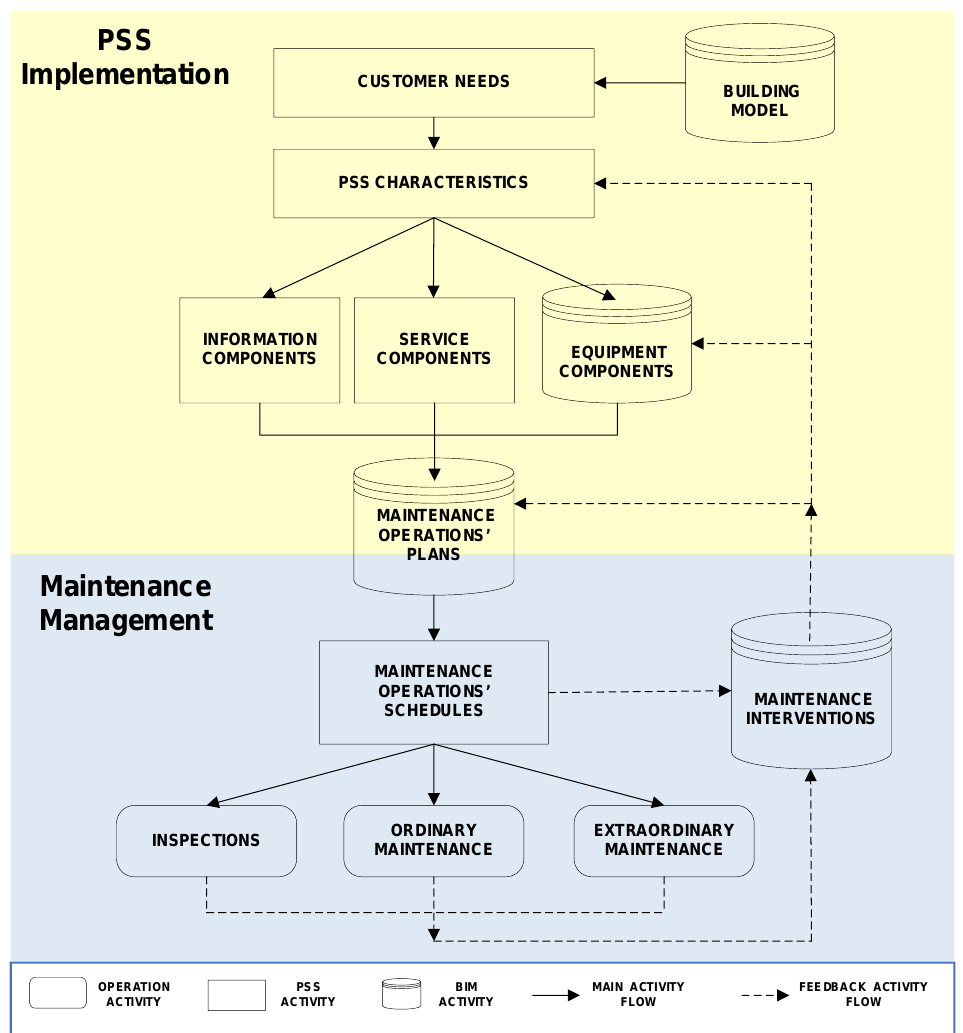
Figure 3. The BIM-PSS Maintenance Management Framework.